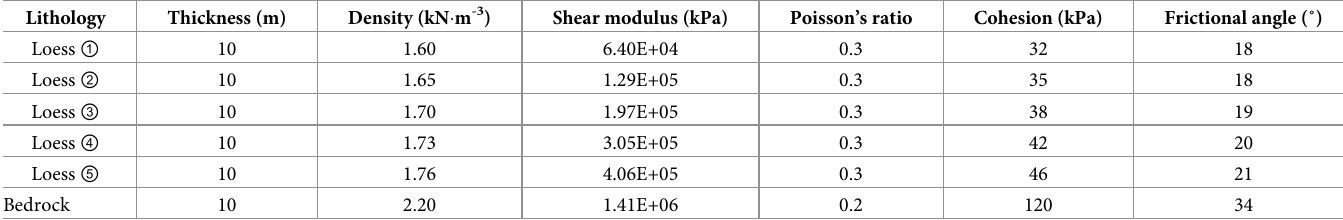
Table 1. Soil mechanical parameters of the finite element model.